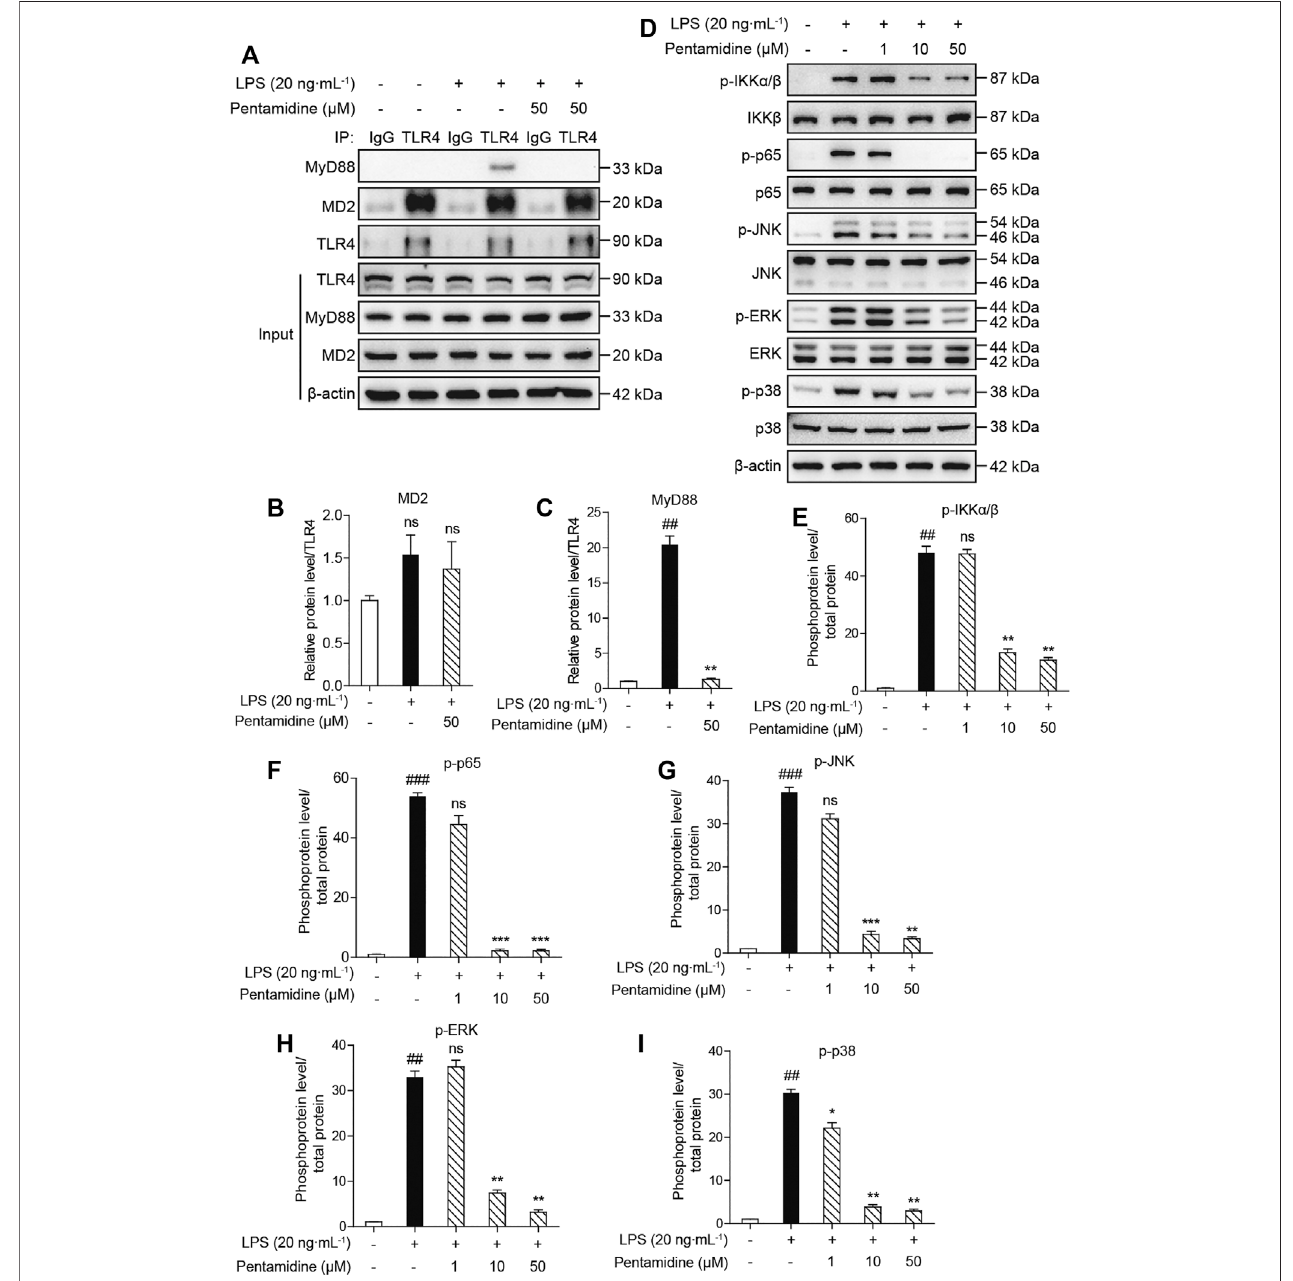
FIGURE7| Cellular characterizations ofpentamidineon TLR4signaling.RAW 264.7cells wereadministeredwith 20 ng ml − 1 LPS and theindicated concentration ofpentamidinefor1 h (A – C) Co-immunoprecipitationofanti-TLR4antibody.MD2,TLR4,andMyD88weredetectedbyWesternblotting. (D – I) Theeffectofpentamidine onLPS-inducedphosphorylationofIKK β ,p65,andMAPKs.Theproteinlevelof β -actinwassetasareference.Allexperimentswereperformedthriceindependently,and dataweregivenasthemean±S.E.M.##, p < 0.01versusthecontrol;###, p < 0.001versusthecontrol;**, p < 0.01versustheLPSgroup;***, p < 0.001versusthe LPS group; ns, not signi fi cant.